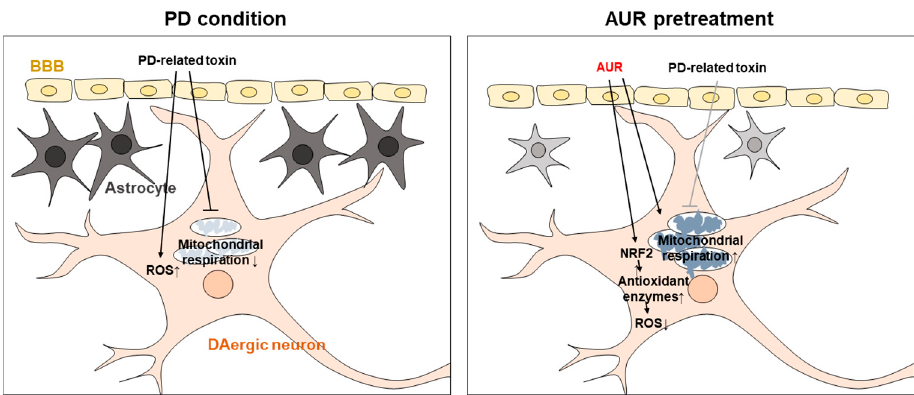
Figure 6. Schematic representation of the dopaminergic neuron-protective mechanism of AUR in a PD model. AUR alleviates neurotoxin-induced oxidative stress in dopaminergic neurons by stimulating the transcription factor NRF2 and inducing expression of downstream genes encoding antioxidant enzymes. Inhibition of mitochondrial respiration by PD-related toxins is mitigated by AUR treatment. AUR protects dopaminergic neurons against neurotoxins and ameliorates PD-like behavior.